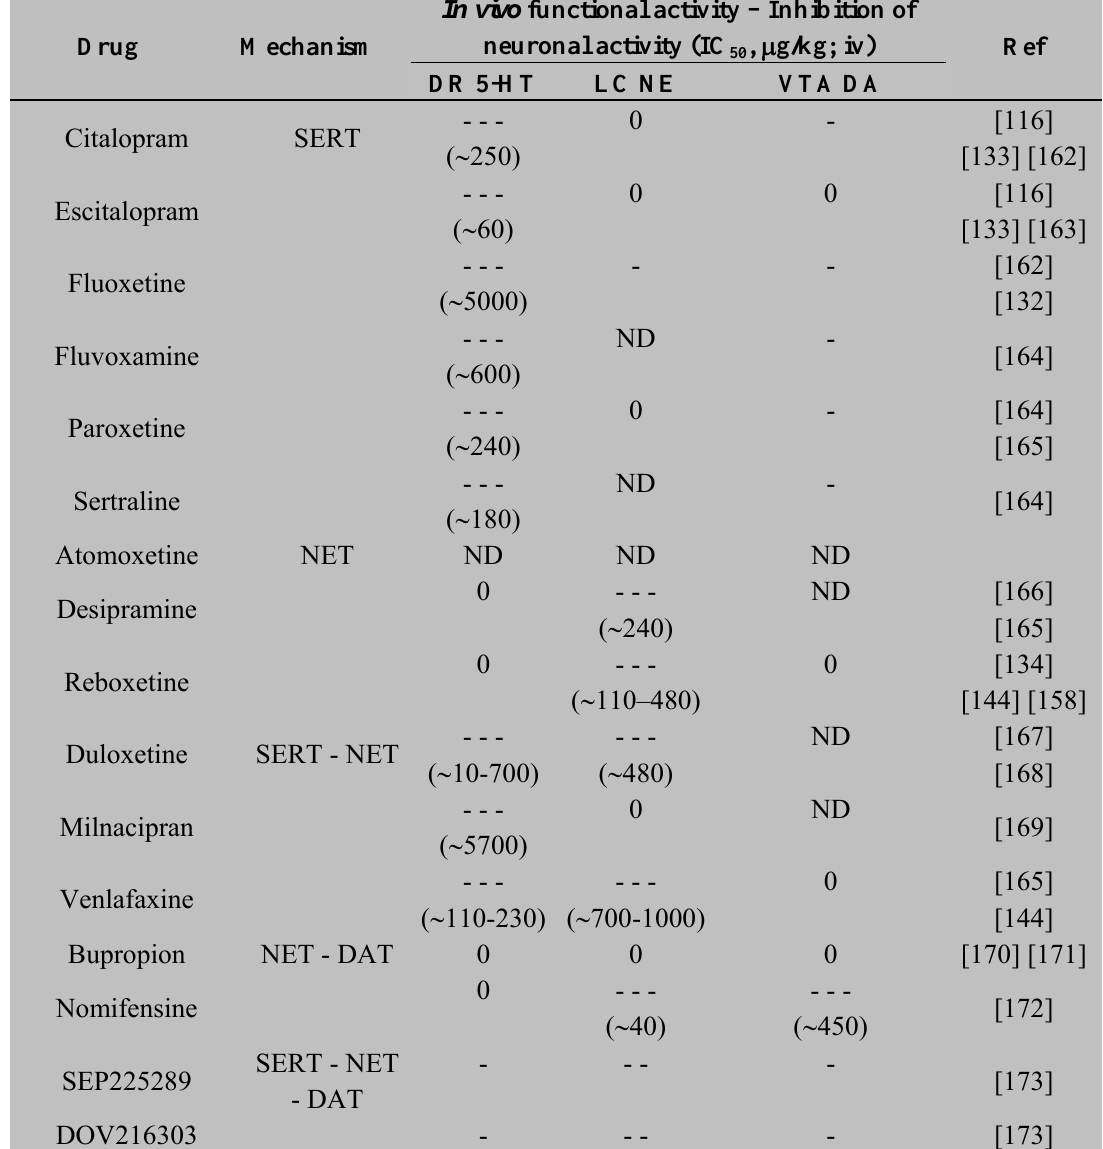
Table 2 . In vivo elecrophysiological effects of monoaminergic reuptake inhibitors on the firing activity of DR 5-HT, LC NE and VTA DA neurons in rats. [---]: 100% of inhibition, [--] between 50 and 100% of inhibition, [-] <50% inhibition, (0) No significant effect, (ND): Not Determined. Values into brakets indicate the dose that produces 50% of complete inhibition of neuronal activity (IC 50